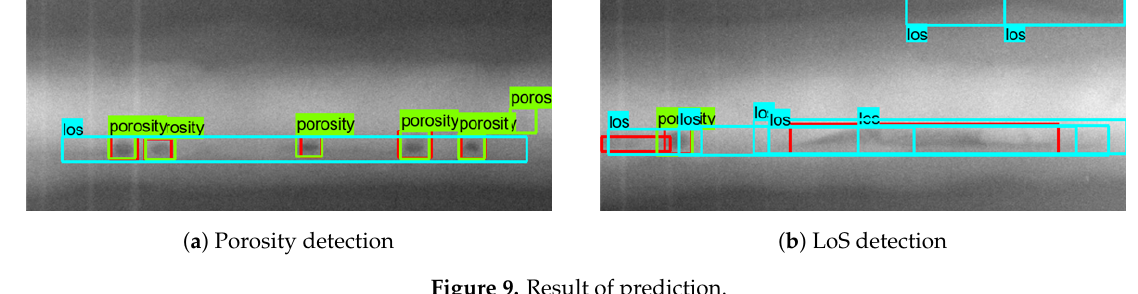
Figure 9. Result of